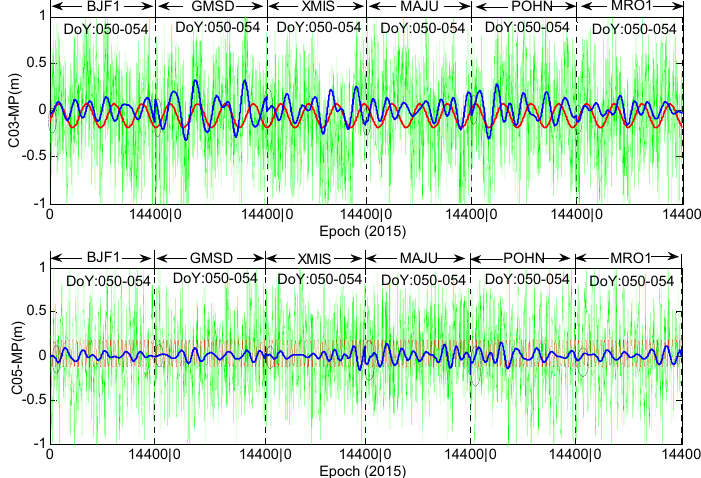
Figure 6. The multipath series of C03 and C05 at the other six stations. Green is the multipath estimation; red is the Fourier fitting results of the multipath series; blue is the wavelet reconstructed multipath series; the cycle is the edge of reconstructed multipath series between different stations.